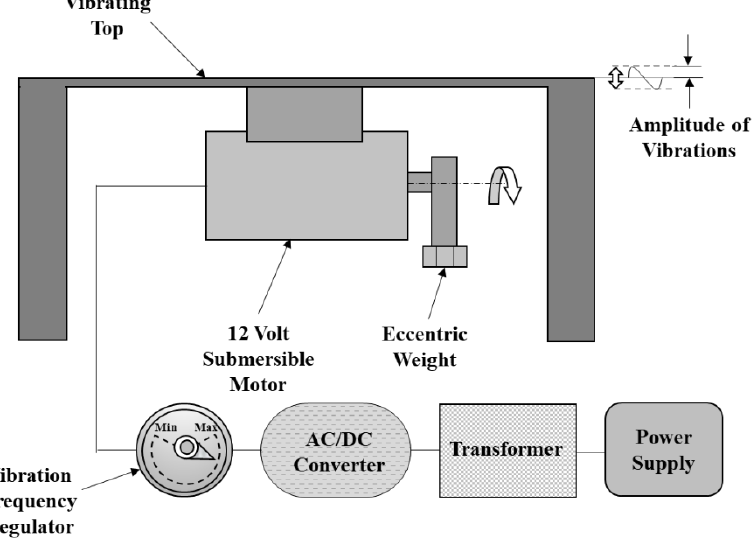
Figure 1. Schematic of the Vibration Platform.